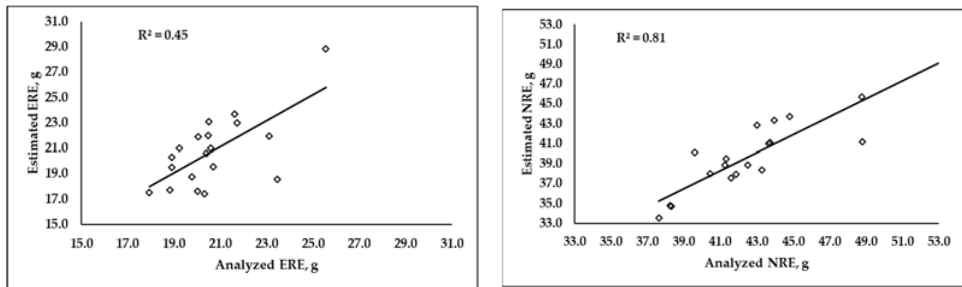
Figure 3. Correlation between overall Energy Retention Efficiency (ERE) and overall Digestible Nitrogen Retention Efficiency (NRE), calculated using analyzed or predicted by MLR carcass composition values.